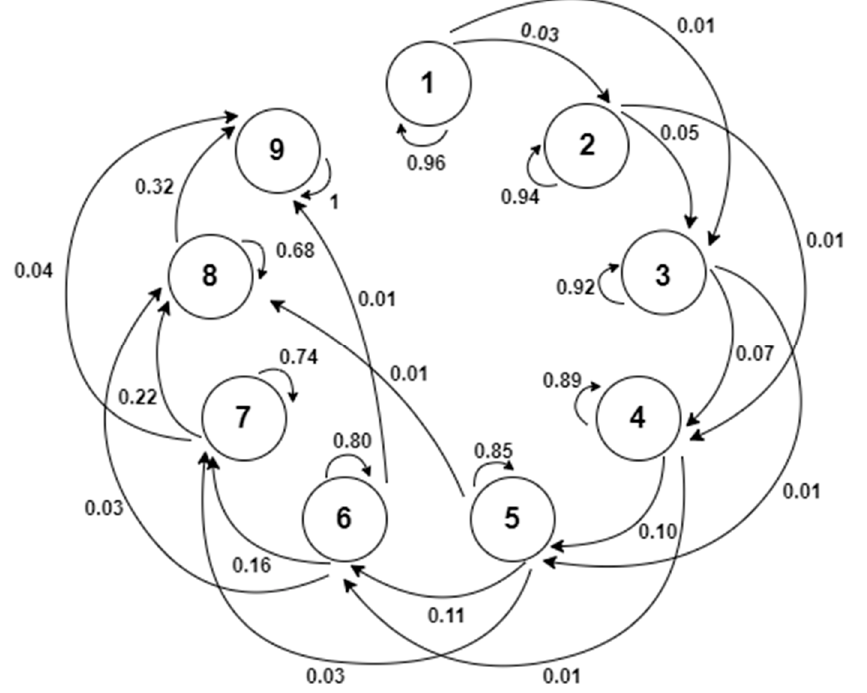
Figure 2. System transition graph.